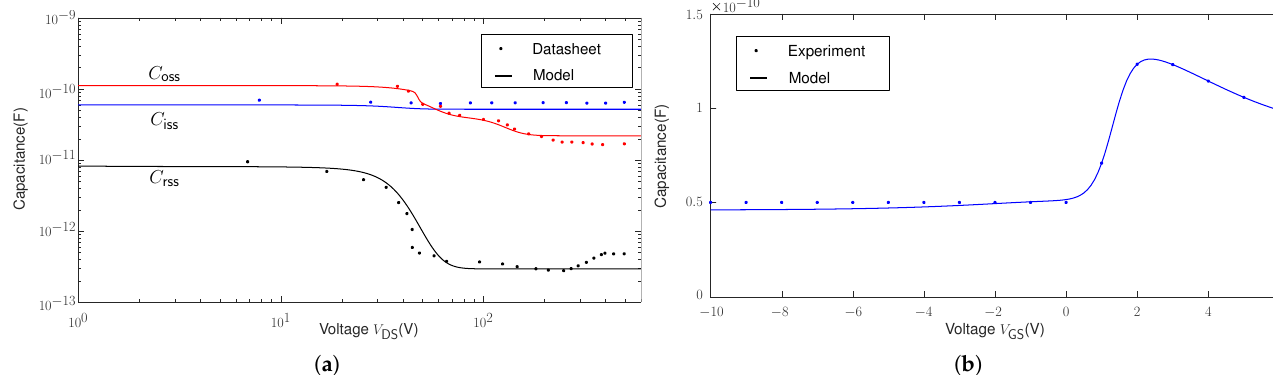
Figure 3. Comparison between the model and datasheet or experiment for device interelectrode capacitance values: ( a ) C iss , C oss and C rss values. ( b ) C gs - V GS